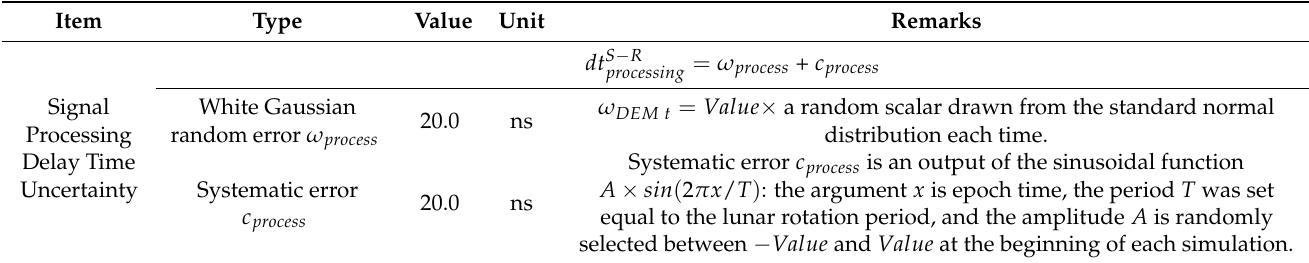
Table 10. Overview of the signal processing delay time uncertainty used in the simulation.